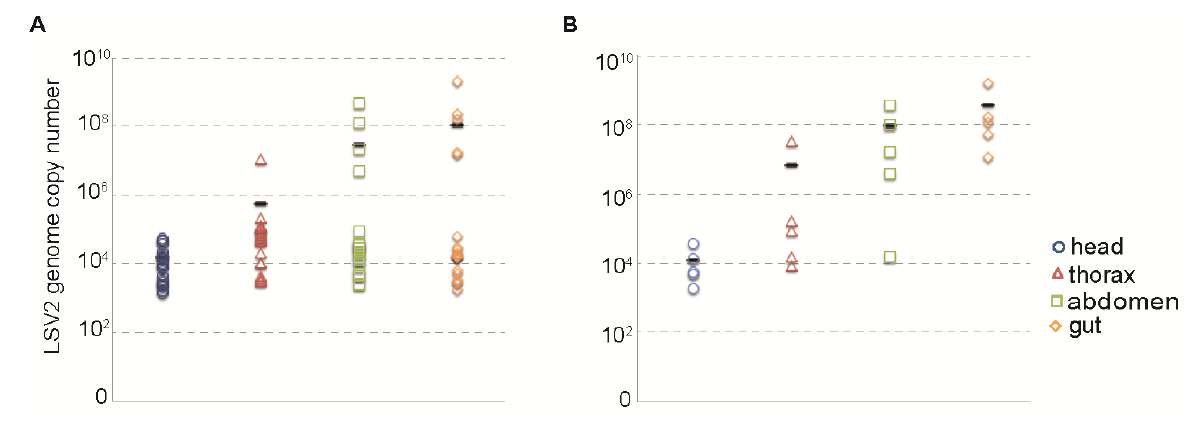
Figure 4. Relative distribution of LSV2 in honey bees. ( A ) LSV2-infected adult honey bees (n = 22) were dissected (head, thorax, abdomen, and gut) and the relative abundance of LSV2 was assessed by qPCR. The average copy number per 1 µg RNA of each region (x-axis) is as follows: head—1.56 × 10 4 , thorax—1.96 × 10 6 , abdomen—2.72 × 10 7 , and gut—1.07 × 10 8 (represented by a black dash); ( B ) Bees with highest LSV2 levels (n = 5) harbored the majority of virus in their gut—4.72 × 10 8 and abdomen—1.19 × 10 8 average copy number per 1 µg RNA (black dash), compared to lower copy numbers detected in the thorax—8.42 × 10 6 and head—1.55 × 10 5 regions.